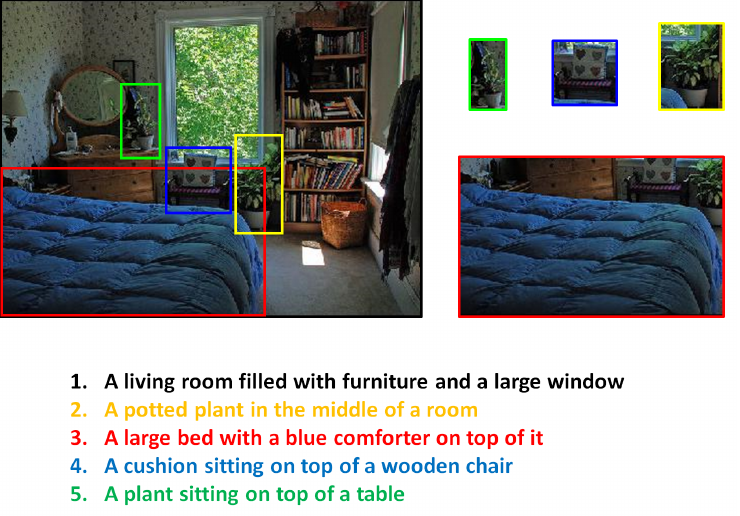
Figure 3. An example regional caption generation. Regions are detected using YOLO-V3 [1], and captions are generated using Show, Attend, and Tell